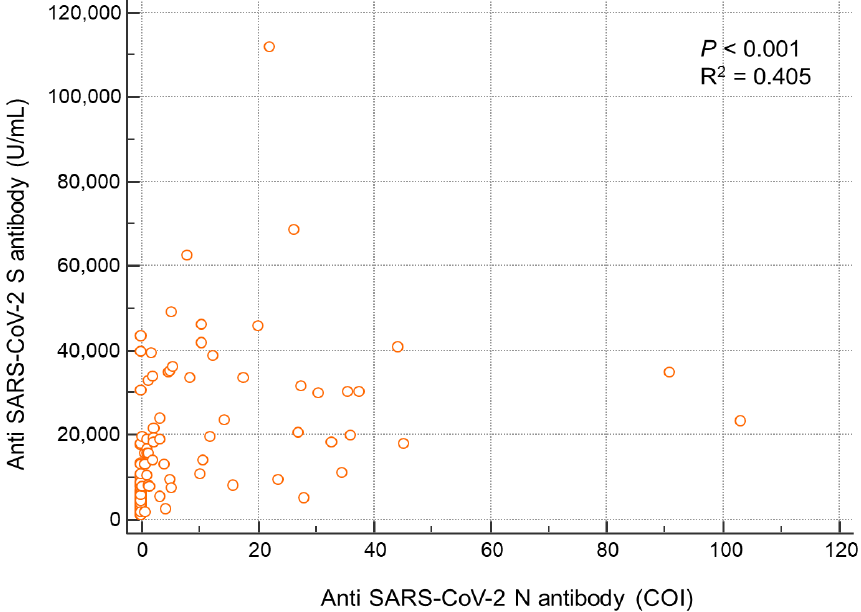
Figure 4. Correlation between anti-S and anti-N antibody levels in each participant.